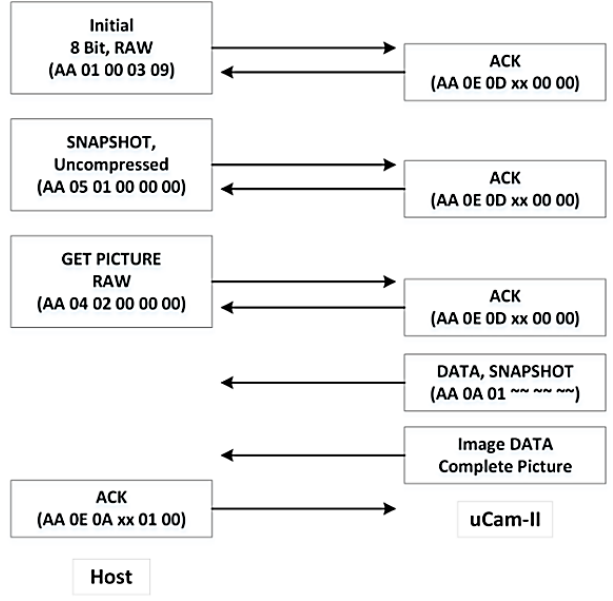
Figure 5 . Process of capturing an 8-bit 128 × 128 raw image.